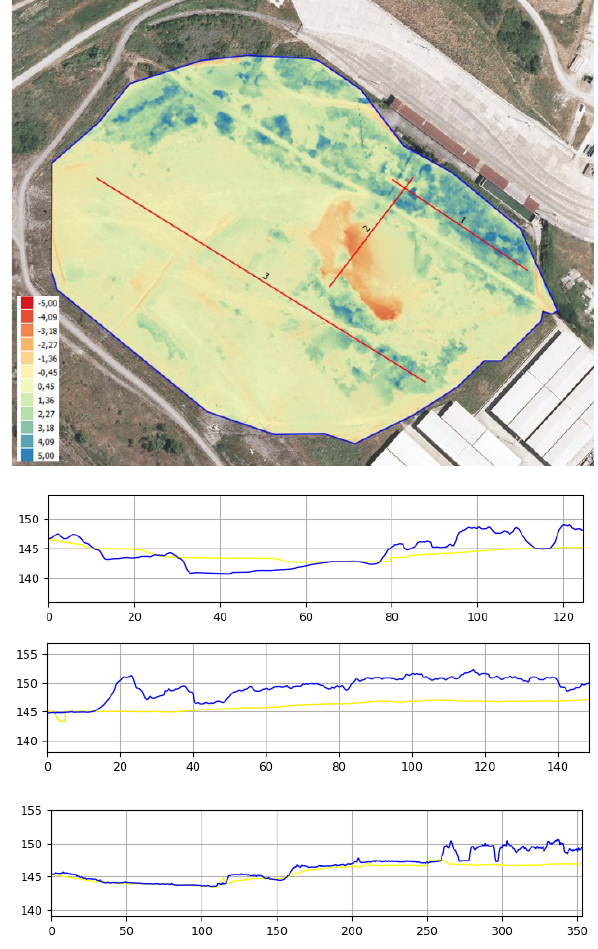
Figure 10 . Cross Section of digital elevation models in vegetated areas (yellow: RPAS initial survey before vegetation removal; blue: 1.2000 elevation model dated to 1999).